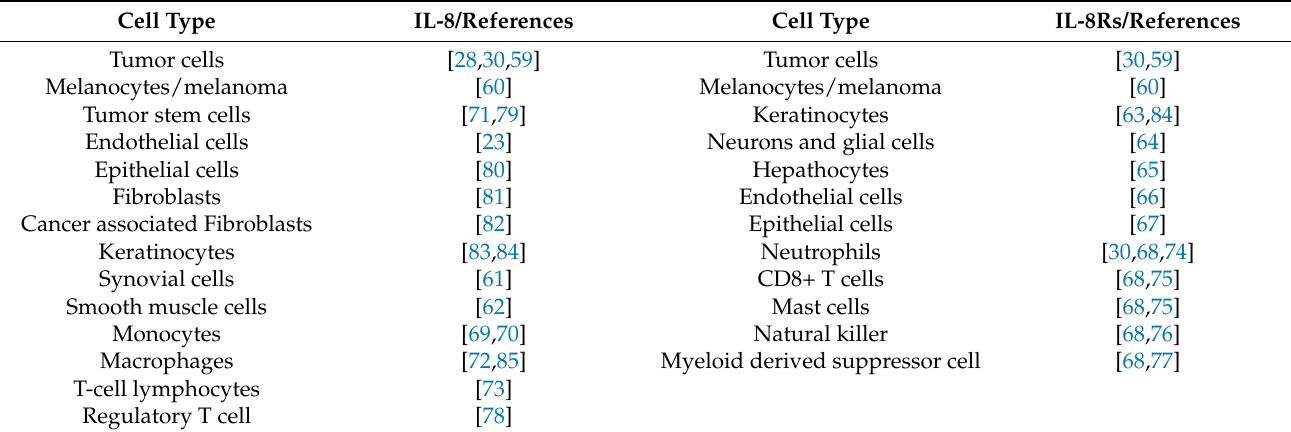
Table 1. The expression of IL-8 and IL-8Rs in different cell